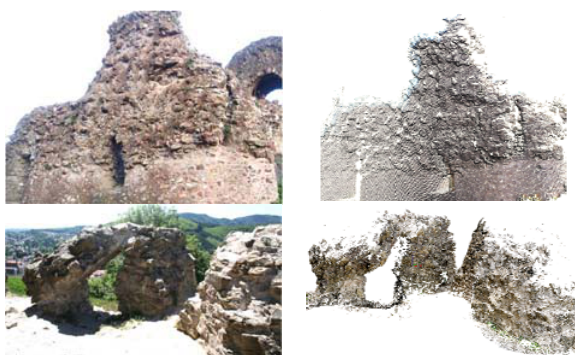
Figure 14. Photos (left) and corresponding coloured point cloud from Photosynth